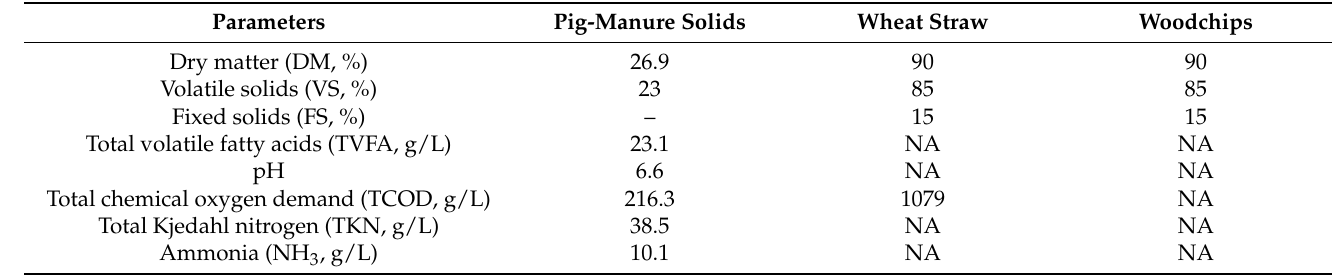
Table 2. Physico-chemical characteristics of pig-manure solids and wheat